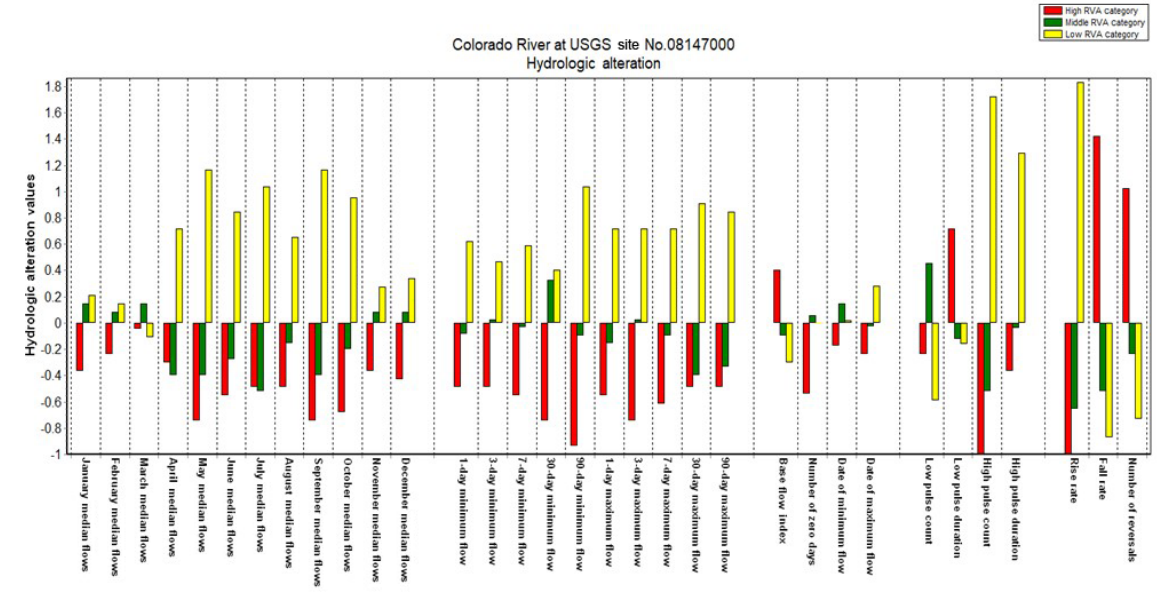
Figure 6. Hydrologic Alteration factors for Colorado River near San Saba.